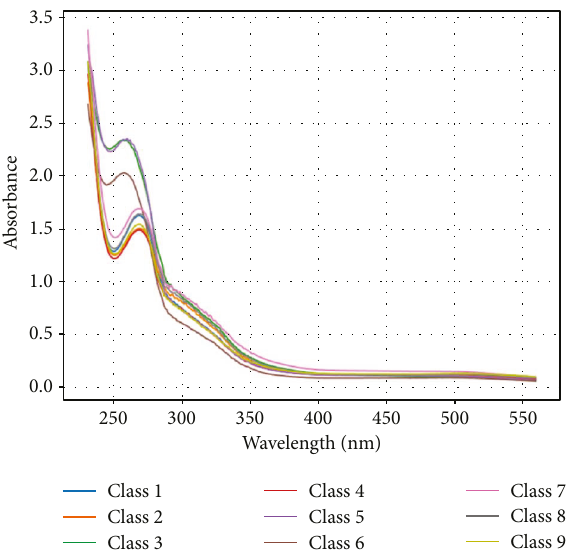
Figure 2: Typical UV-Vis spectra of nine kinds of red wine.